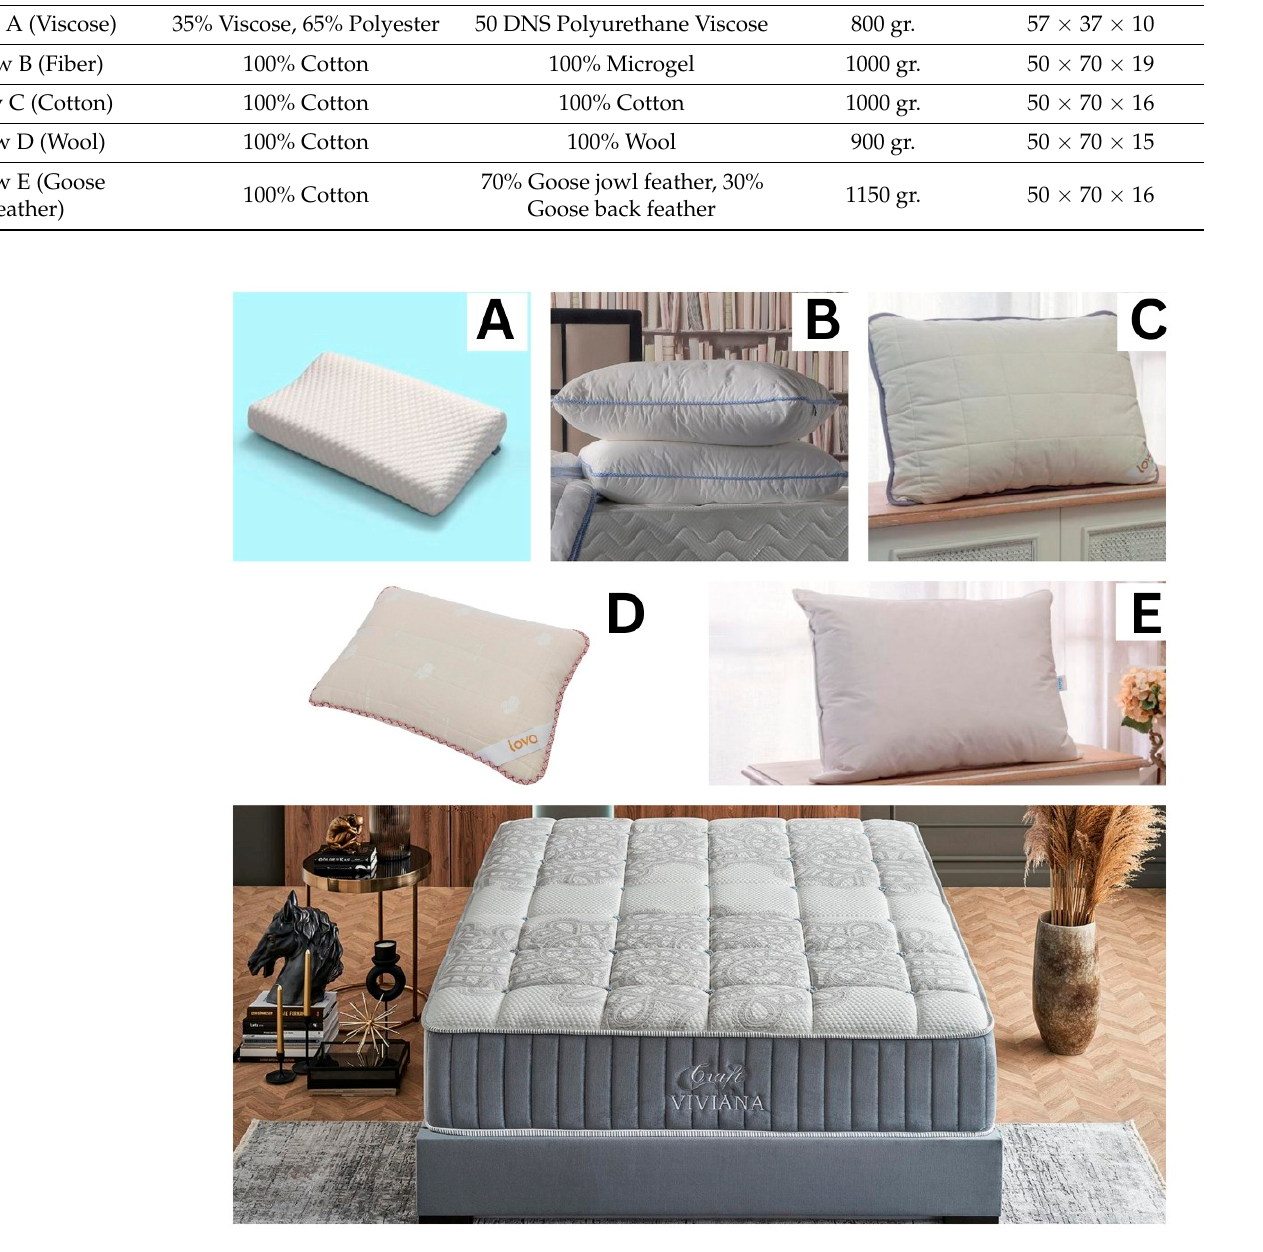
Figure 2. Mattress and pillows used in the research. ( A ). Viscose pillow, ( B ). Fiber pillow, ( C ).